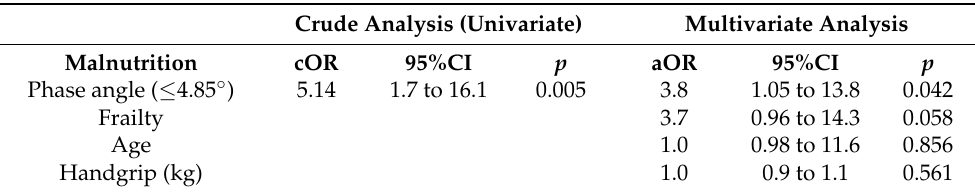
Table 5. Odds ratios of malnutrition in patients with phase angle ≤ 4.85 ◦ (dependent variable) by frailty, age, and handgrip. Crude analysis and adjusted